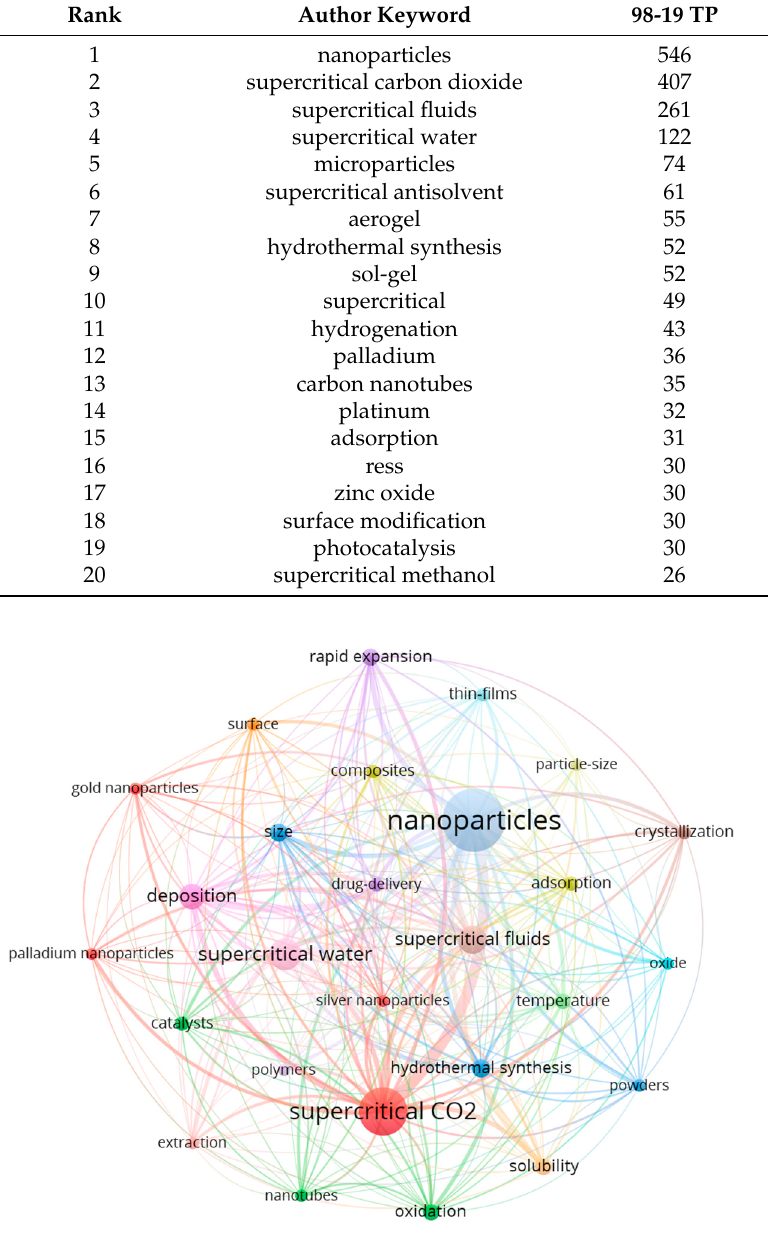
Figure 6. Author’s keyword cluster map for 1998 to 2020.